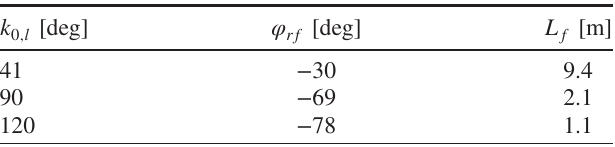
TABLE V. Longitudinal zero current phase advances and corresponding focusing lengths and rf phases applied in the